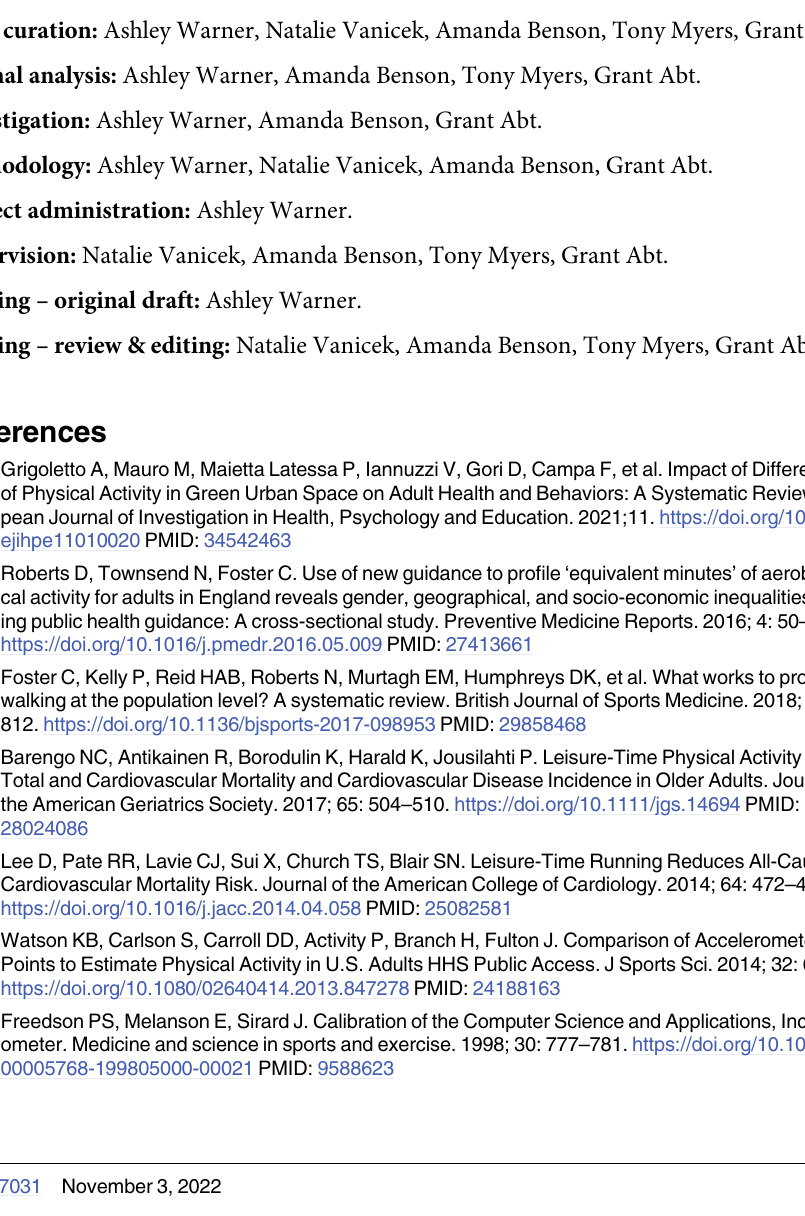
S1 Table. The modified Downs and Black scale used to rate quality of included studies. S2 Table. The modified Downs and Black score for each included